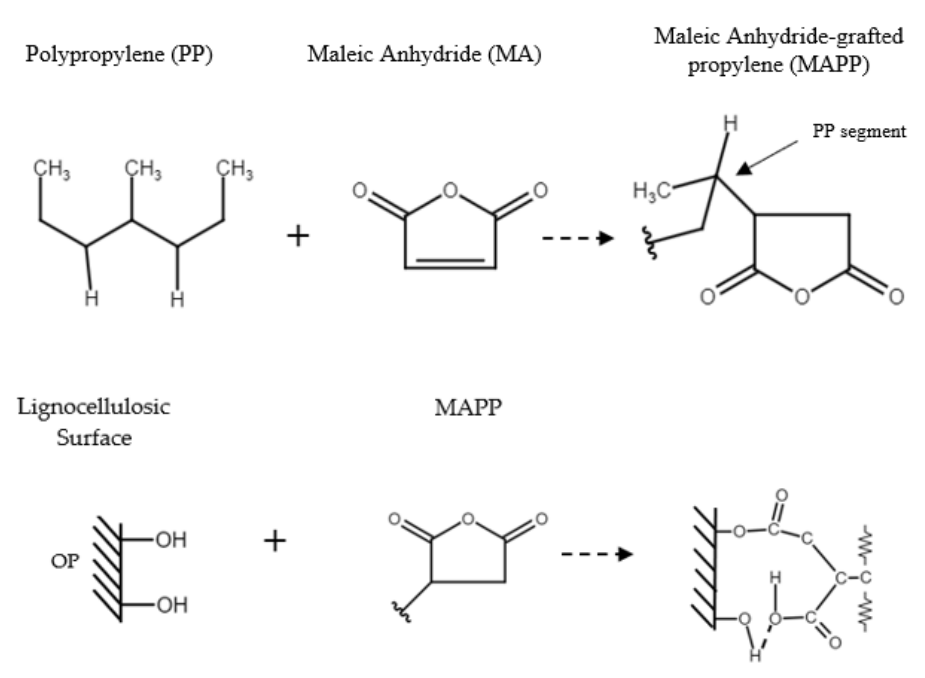
Figure 17. Mechanism of interaction between PP, MAPP and OP.